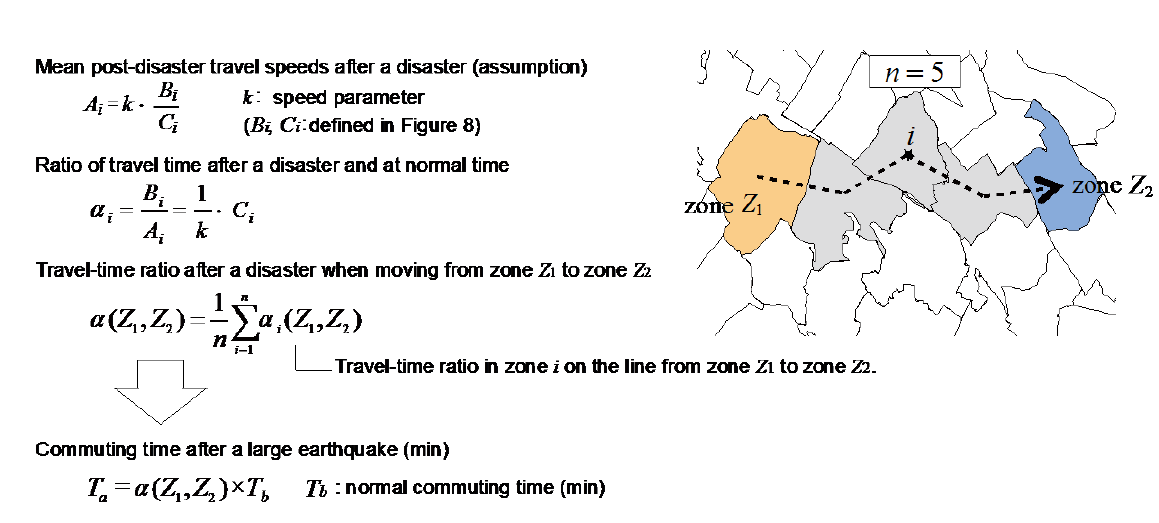
Figure 11. Method of assessing commuting times after a major earthquake by taking into account the increased degree of road